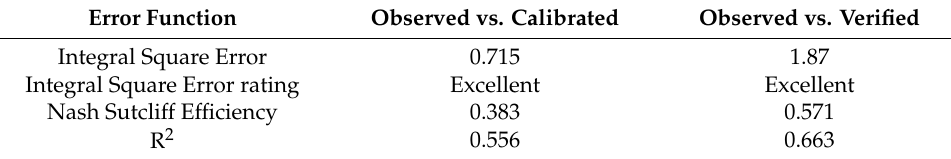
Table 5. Calibration of